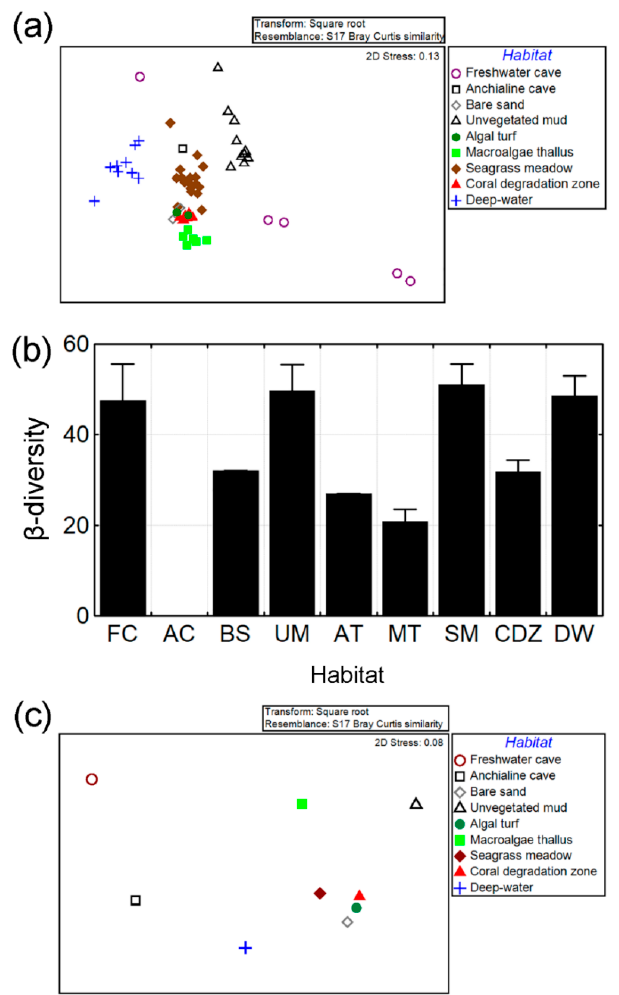
Figure 4. ( a ) Numerical ordination by non-metric multidimensional scaling (NMDS) of the samples coded by habitat type and based on square-root transformed abundance of nematodes. ( b ) β -diversity per habitat type represented as the mean (± standard deviation) of distance to centroid based on Bray–Curtis index. Note that β -diversity could not be computed in AC because only one site. ( c ) NMDS of habitats. Acronyms of the habitats: FC = freshwater cave, AC = anchihaline cave, BS = bare sand, UM = unvegetated mud, AT = algal turf, MT = macroalgae thallus, SM = seagrass meadow, CDZ = coral degradation zone, and DW = deep water.